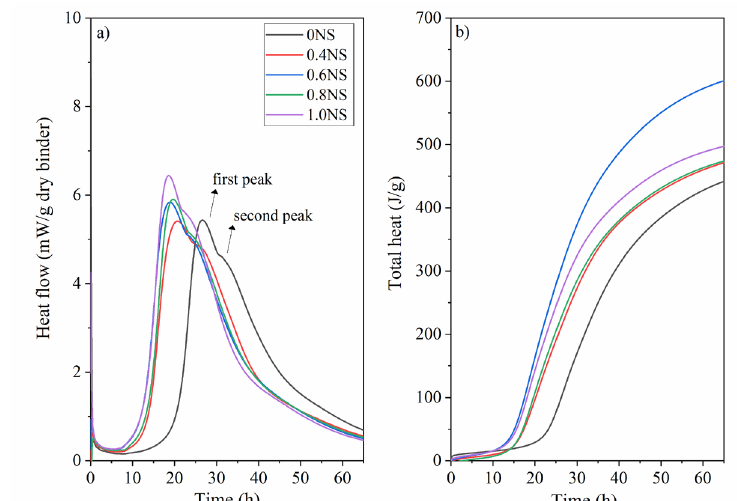
Figure 6. Effect of NS on cement pastes on isothermal calorimetry results. a) heat flow and b) total heat